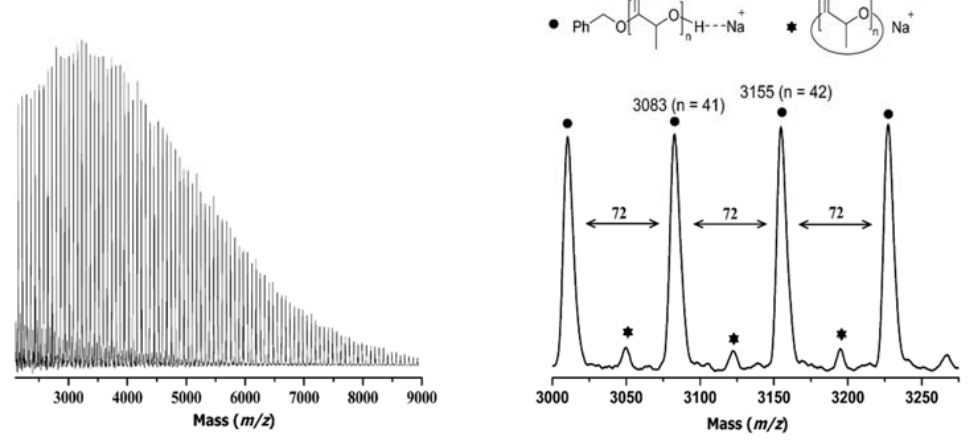
Figure 3. The MALDI ‐ TOF mass spectrum of resulting polylactide using BnOH as an initiator